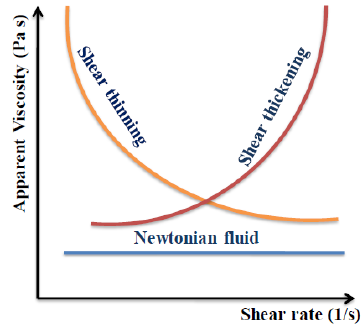
Figure 2: Apparent viscosity versus shear